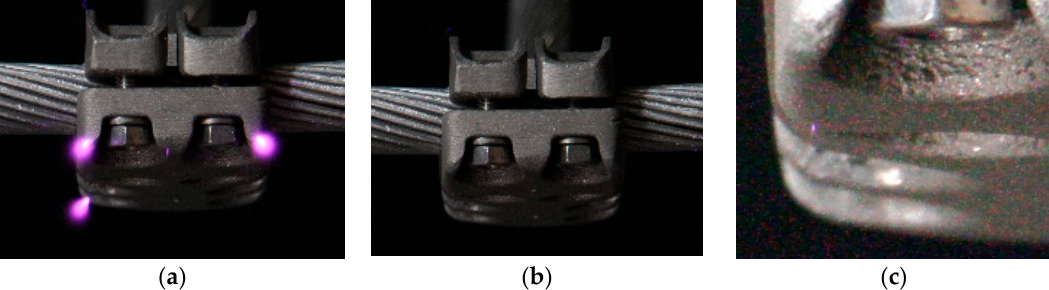
at 84.9 kV; ( c ) Zoom of Figure 9b.